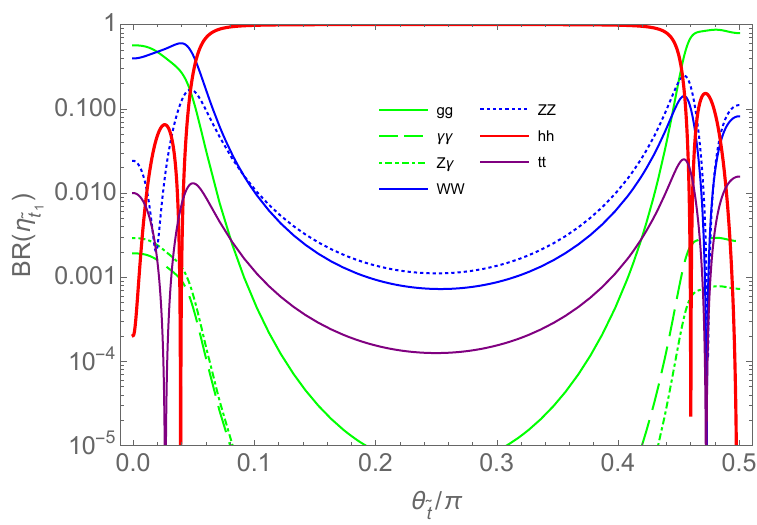
Figure 1 . The decay branching ratios of the stoponium with respect to the mixing angle (cid:18) ~